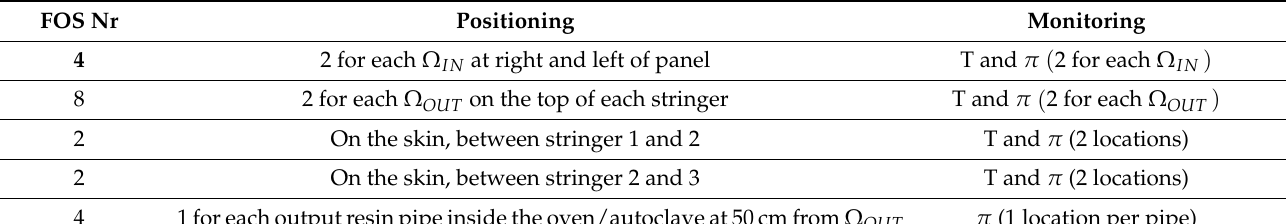
Figure 1. Cross-section of a generic panel “stringerized” and prepared for the infusion.